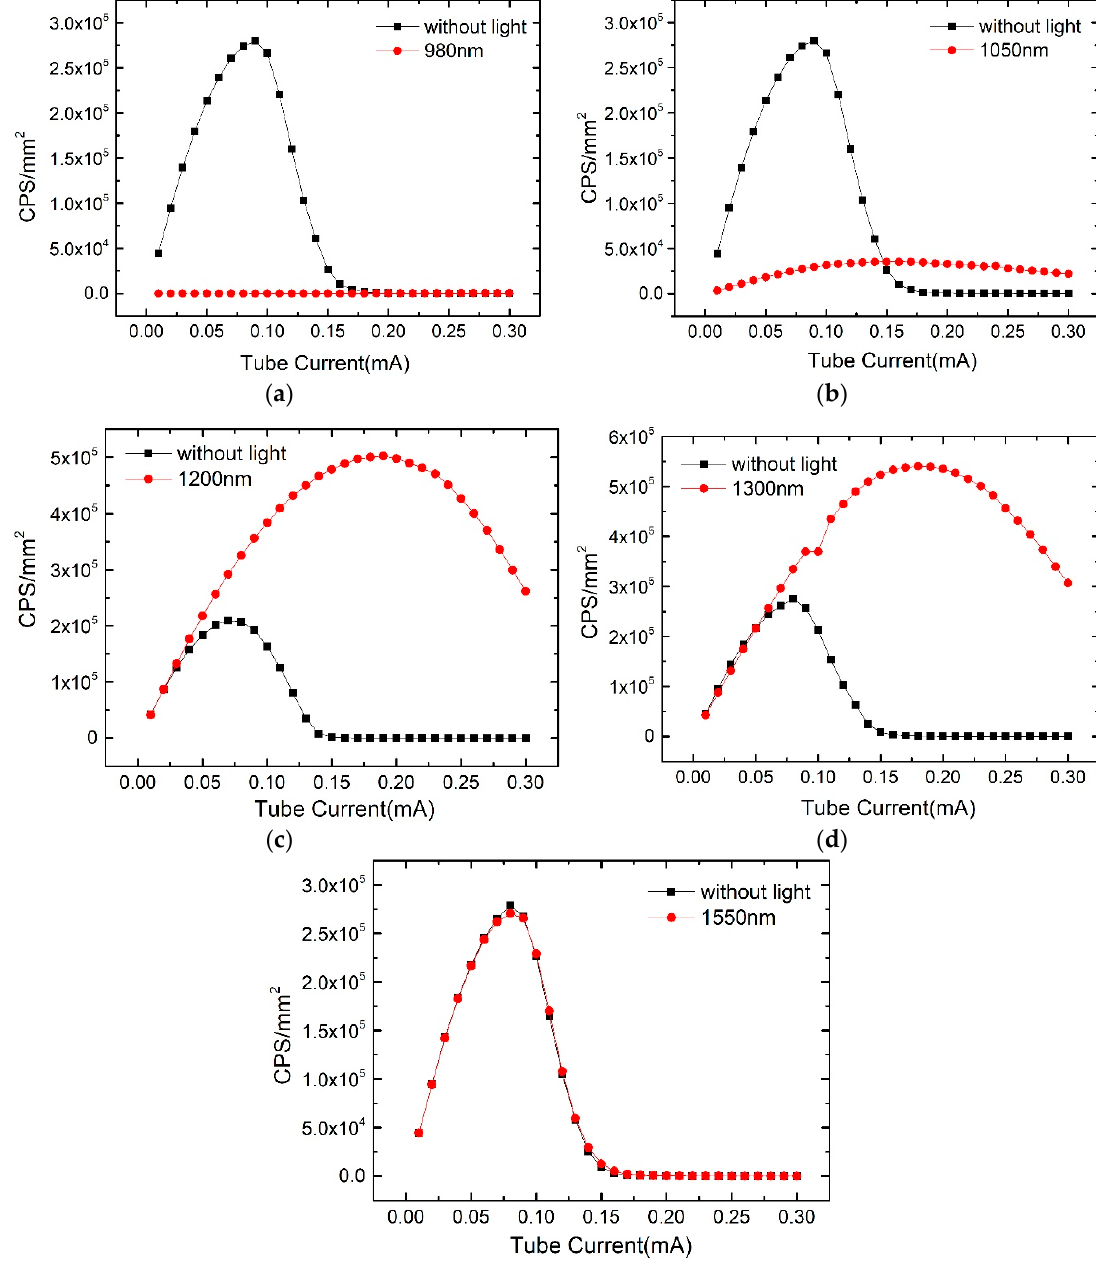
Figure 4. Variations in the count rate under light radiation of the wavelengths of 980 nm ( a ), 1050 nm ( b ), 1200 nm ( c ), 1300 nm ( d ) and 1550 nm ( e ).